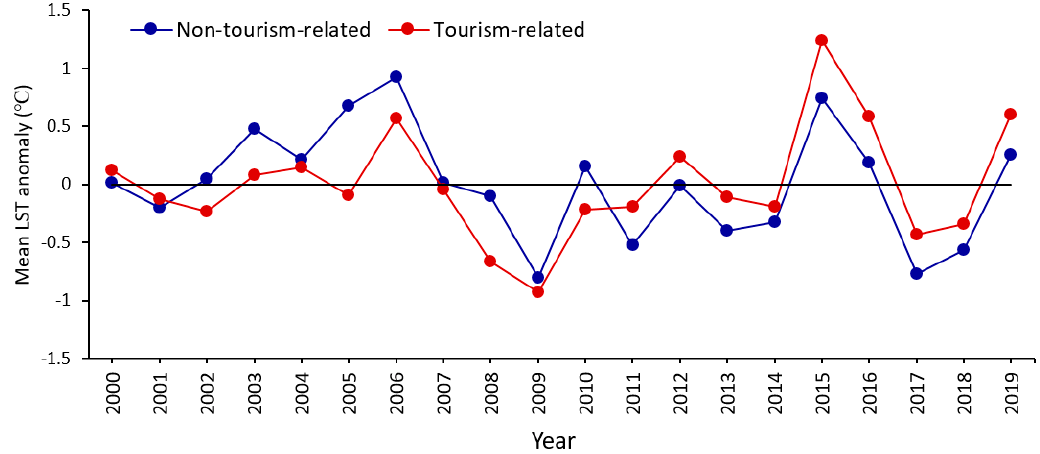
Figure 9. The annual LST anomaly variations for the tourism-related and non-tourism-related sites.